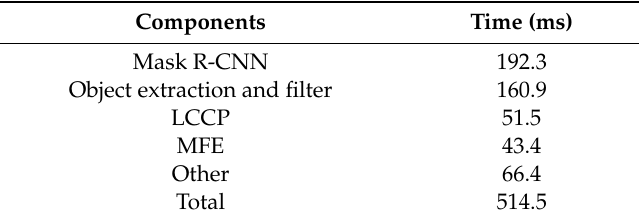
Table 5. Runtime evaluation of our method.